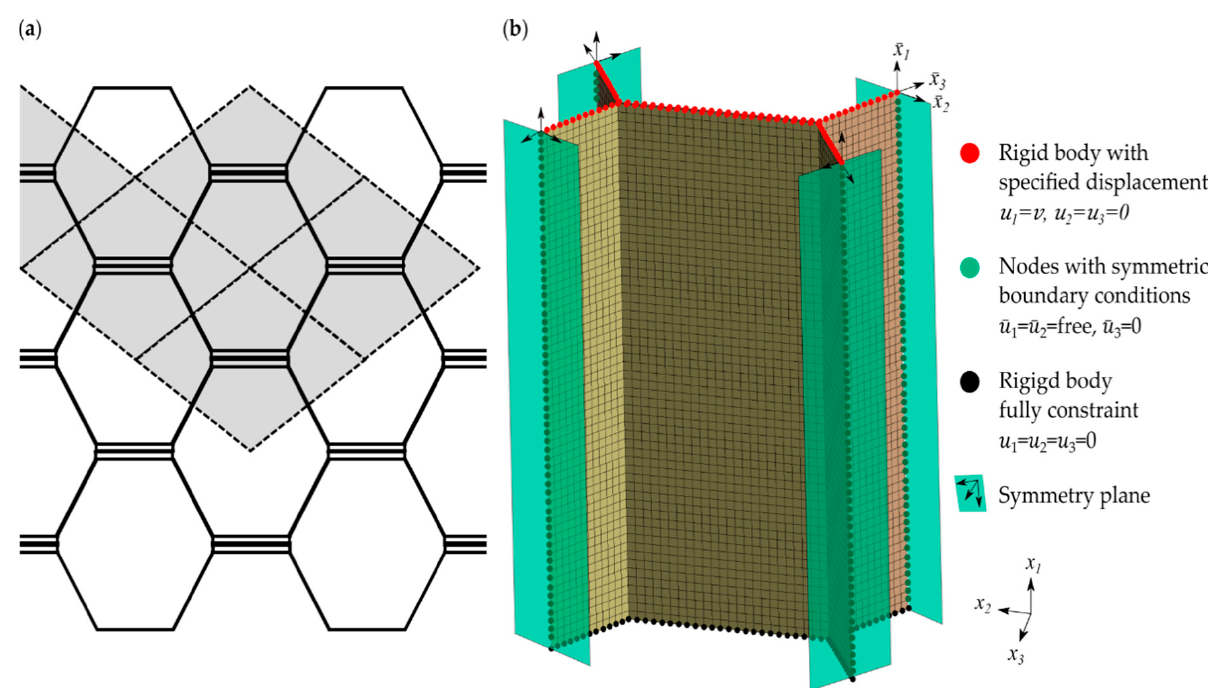
Figure 2. ( a ) Selection of unit cell for buckling analysis, ( b ) unit cell with applied loads and boundary conditions.